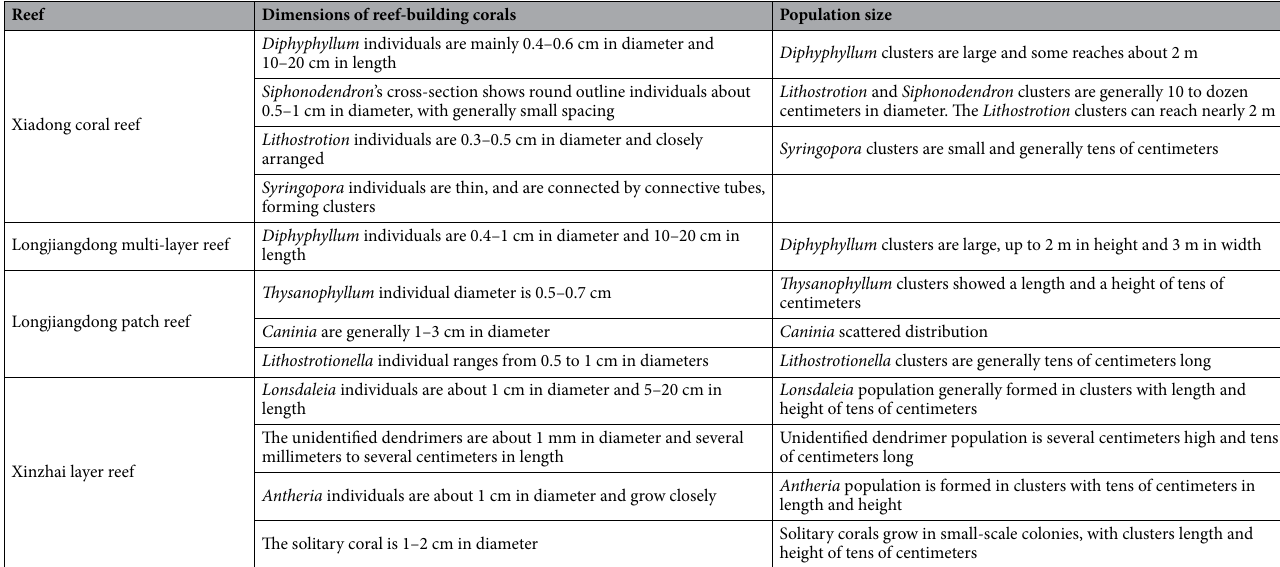
Table.1. General situation of reef-building coral population in